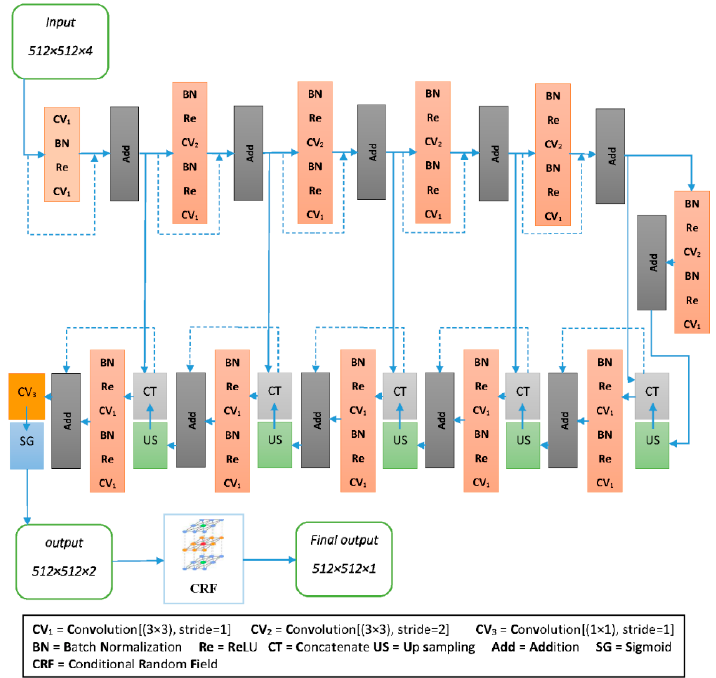
Figure 4. The proposed ResUnet-CRF framework.